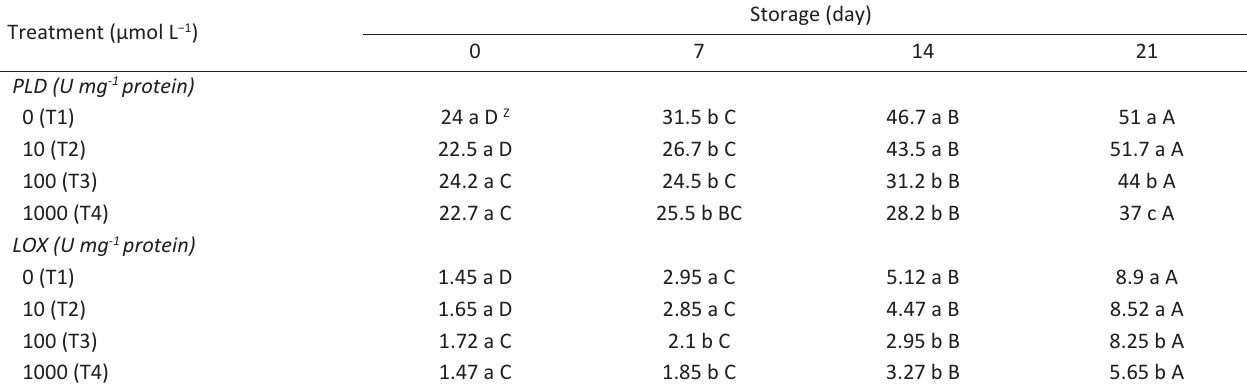
(z) Small and capital letters show significant differences by DMRT at P= 0.05 between treatments in columns, and storage time for each parameter,